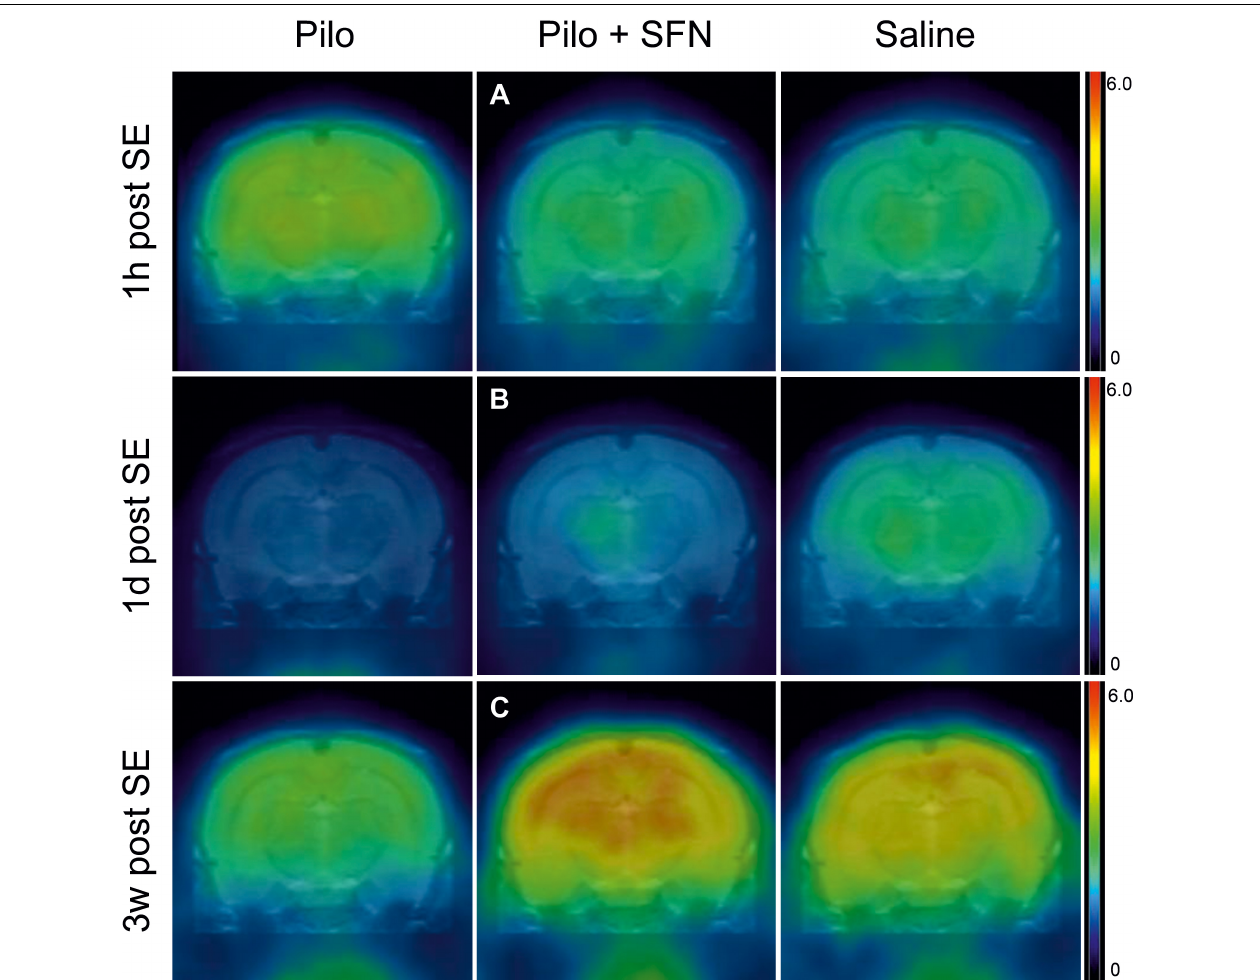
FIGURE 4 | Representative 18F-DG-PET measurements from all the three-time periods, coronal section images taken on the level of the hippocampus and the thalamus. SFN pretreatment prevents hypermetabolism 1 h post-SE (A) , partially restores hypometabolism 1-day post SE (B) , and seems to lead to glucose uptake above both control and Pilo group levels 3 weeks post SE (C) . All the representative samples are reported in the SUV units